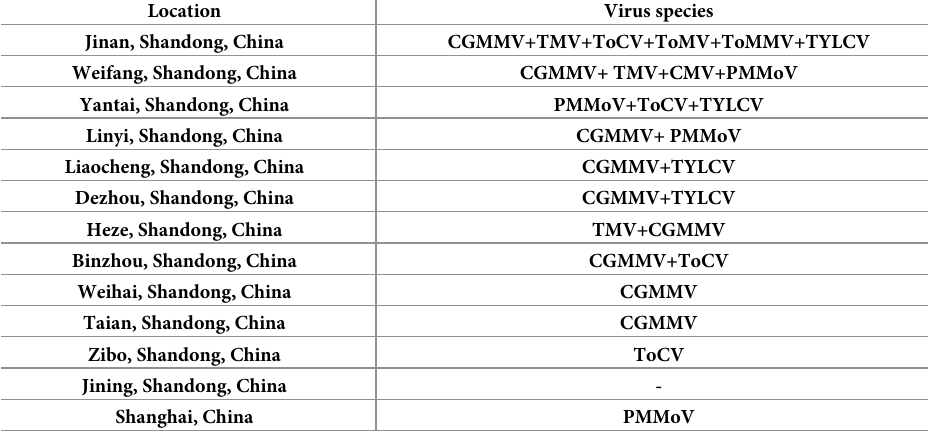
Table 3. Species of plant viruses in surface water from different regions.